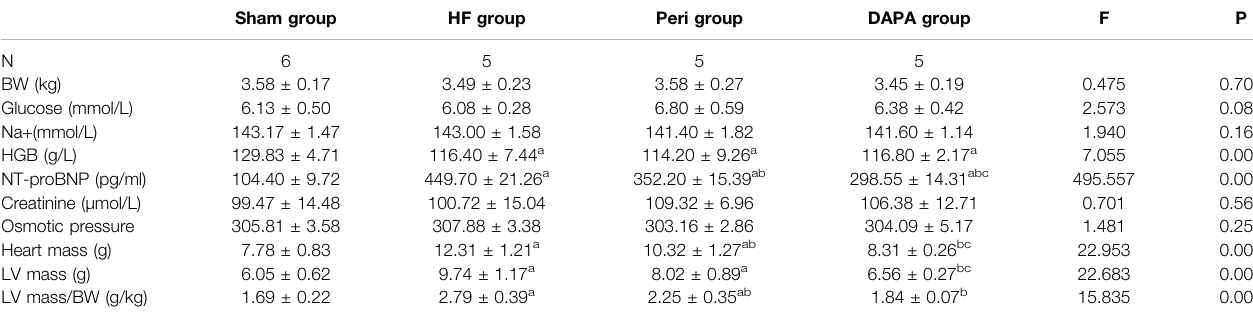
TABLE 1 | Characteristics and biochemical indicators of rabbits after 10 weeks of treatment in four groups.